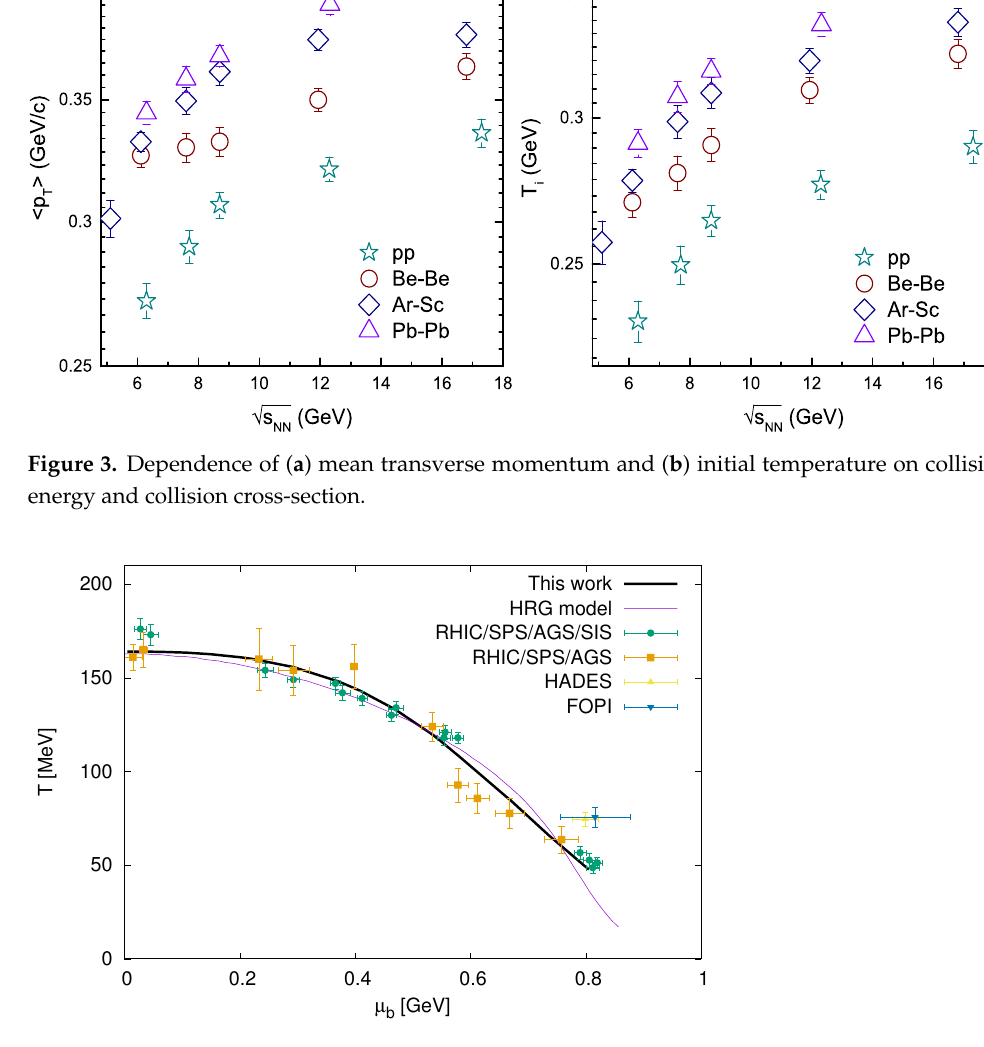
Figure 4. Dependence of the chemical freeze-out temperature on the baryon chemical potential, Equation (1) and Equation (2), respectively. The symbols represent various measurements. The thin curve stands for results obtained by the HRG model at constant higher-order moments of particle multiplicities. The curve label “This work” in the legend is determined by the statistical hadronization model